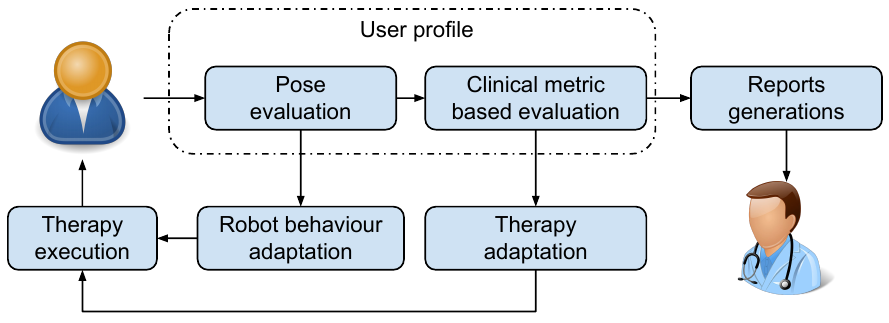
Figure 2. User profiling integration in